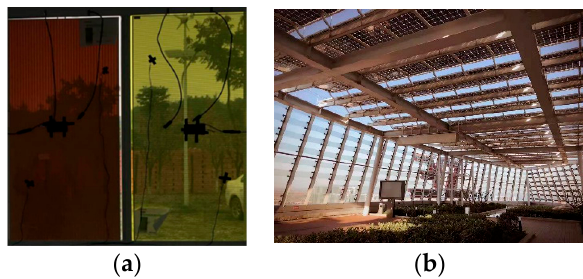
Figure 1. Window integrated with different types of PV cell materials. ( a ) c-Si ( b )